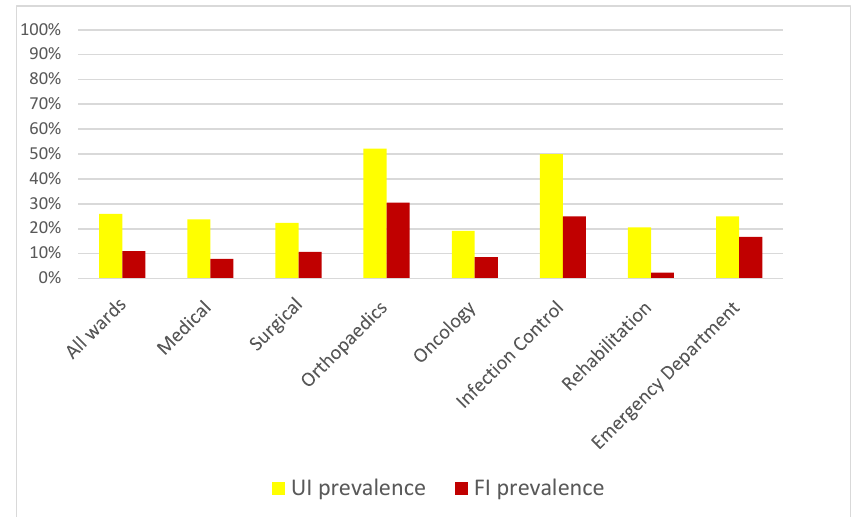
Figure 1. Point prevalence of urinary and faecal incontinence overall and according to ward type in an Irish university hospital. FI: Faecal Incontinence, UI: Urinary Incontinence.